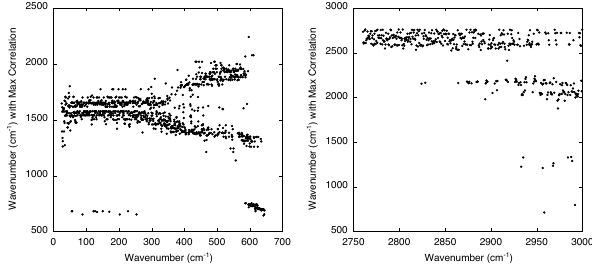
Figure 3. The wavenumbers of IASI observed radiance spectrum ( y axis) that show empirically the maximum correlation coefficients for the FIR (left) and NIR (right) wavenumbers ( x axis), based on a log–log